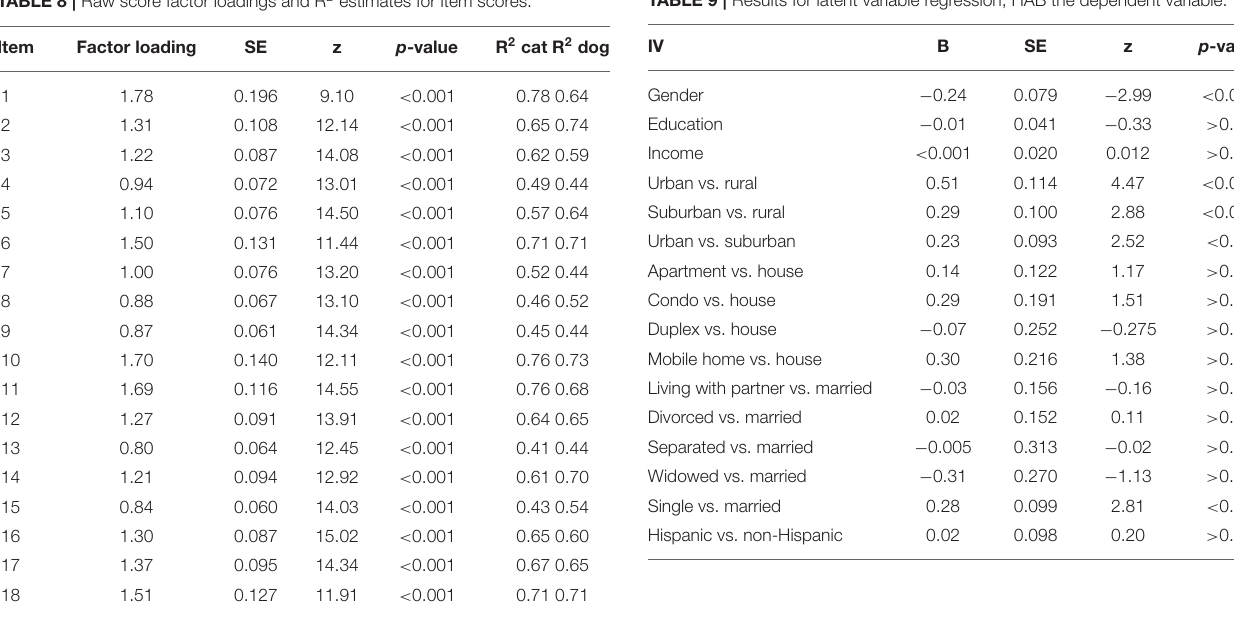
TABLE 8 | Raw score factor loadings and R 2 estimates for item scores. TABLE 9 | Results for latent variable regression, HAB the dependent